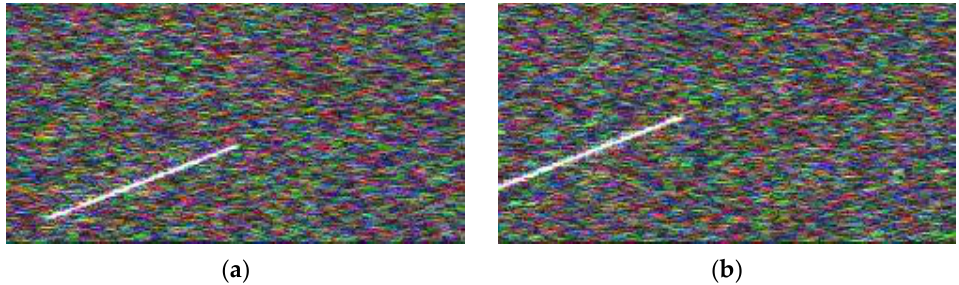
Figure 7. Multi-pulse jamming plus echo time–frequency diagram fusion under low JNR. ( a ) RFTJ + echo. ( b ) VFTJ + echo.